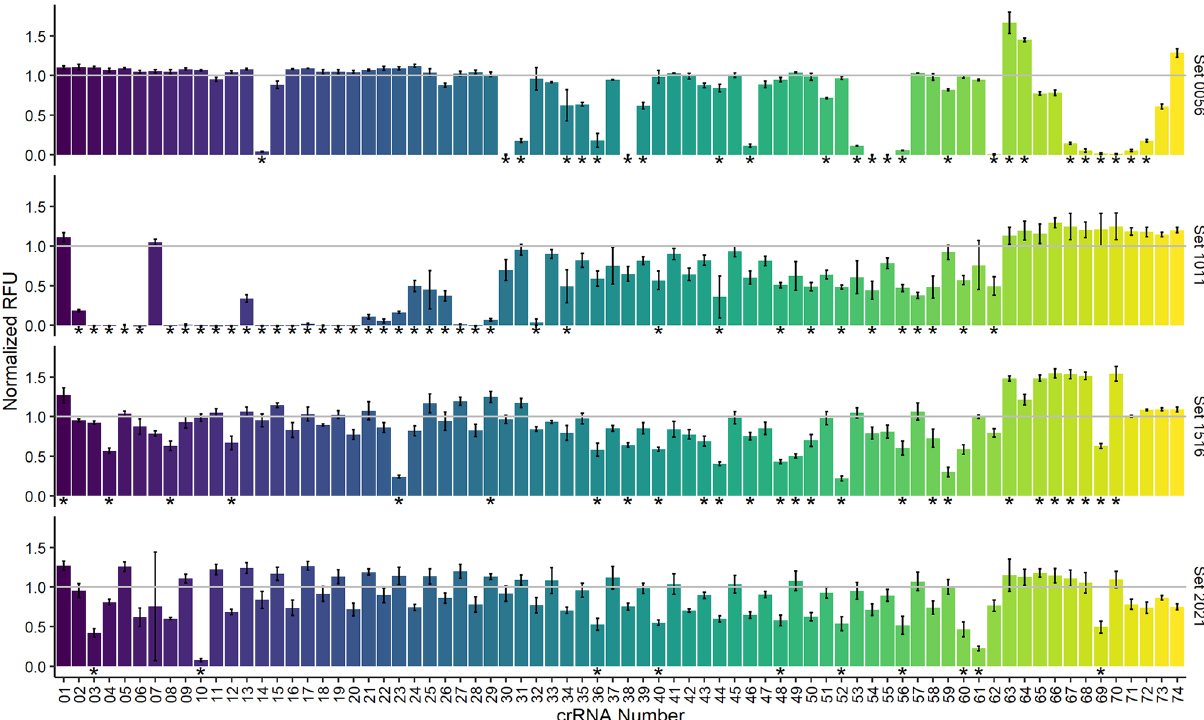
Figure 3. Comparison of Cas13a activation from all tested crRNA across 4 target regions shown as normalized fluorescence sums against internal controls for each set. The crRNA numbers (x-axis) do not correspond to equivalent sequences, but instead crRNA position in their respective series. Bars represent mean and standard deviation is represented by error bars (n = 3), where p -values < 0.05 determined by analysis of variance and Tukey test against internal control are denoted by